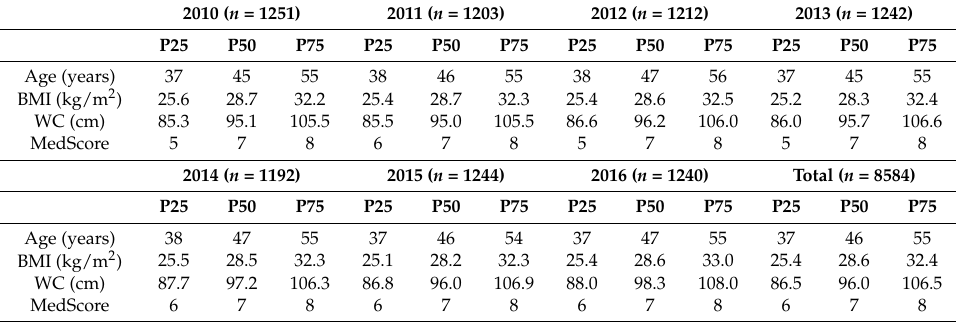
Table 1. General characteristics of the studied sample according to the year of